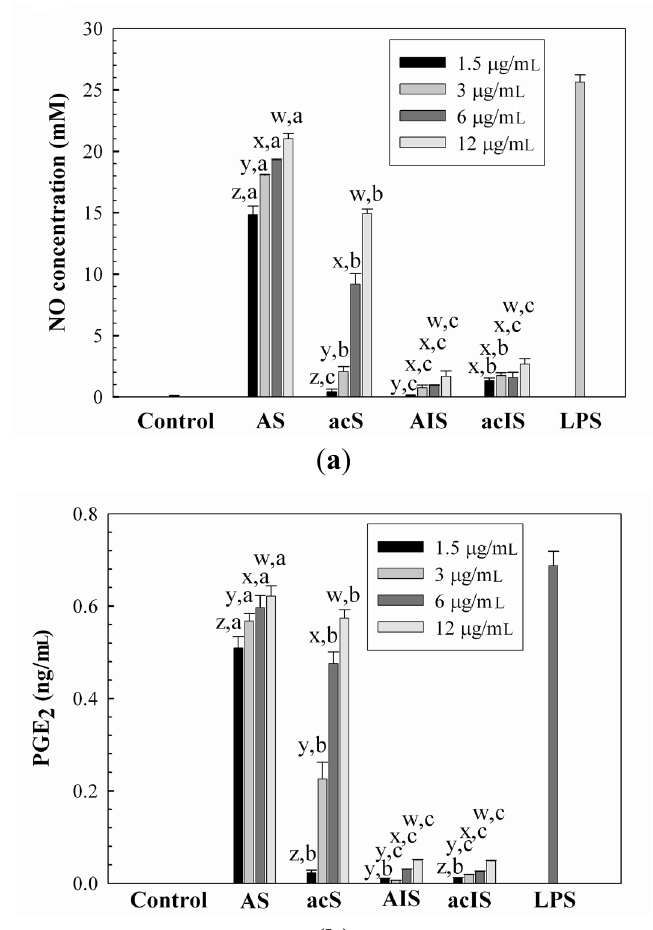
Figure 3. The effects of water-unextractable proteoglycans (F1, F2, F3 and F4) on ( a ) NO, ( b ) PGE and ( c ) IL-1β production. Cells were treated with the proteoglycans (1.5, 3, 6 and 2 12 µ g/mL) or LPS (1 μg/mL) for 24 h. x, y, z indicate a significant difference ( p < 0.01) between the concentrations of the crude and individual fractions; a, b, c, d indicate a significant difference ( p < 0.01) between the crude and fractions at each